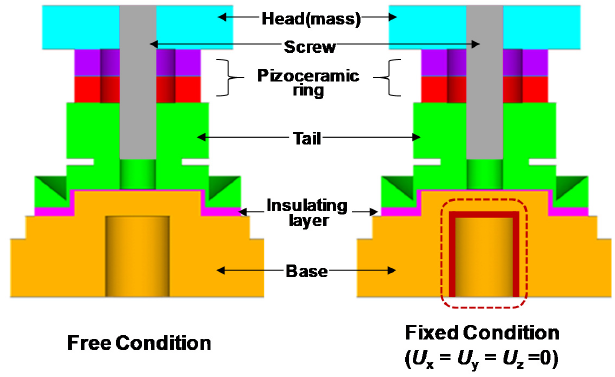
Figure 1. Basic structure of compression-type piezoelectric accelerometer and constituent components used for finite element modeling ( left : Free condition, right : fixed condition).